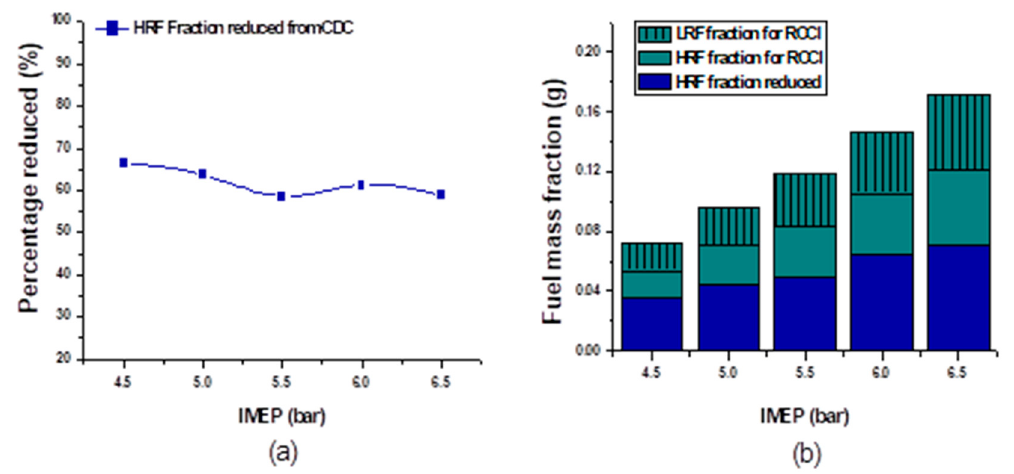
Figure 3. ( a ) An estimated percentage of initial direct-injected fuel reduced and ( b ) analytical mass of fuel injected at various load capacities and a speed of 2000 rpm.